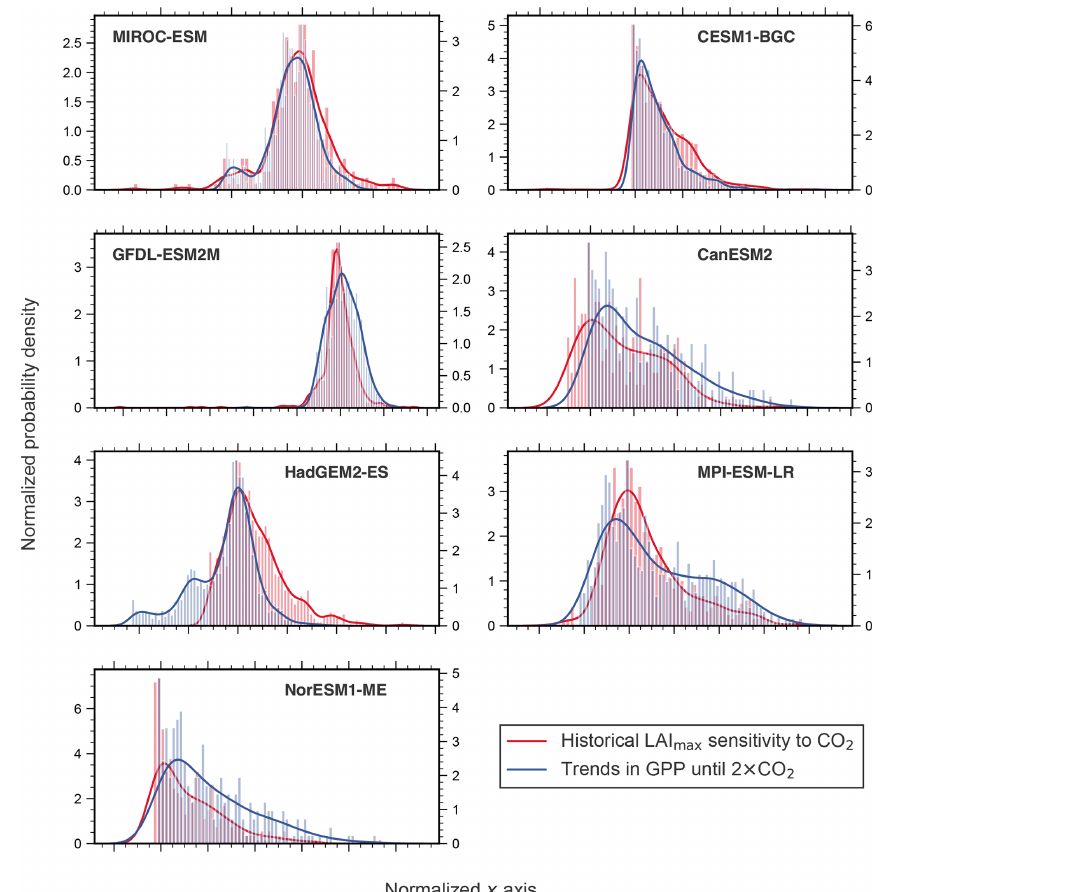
Figure A2. Similar pixel distribution of the predictor and predictand in each model, except HadGEM2-ES. Histograms and associated probability density functions (Gaussian kernel density estimation) of LAI sensitivity to ω (red, left y axis, historical simulations) and temporal trends in GPP (blue, right y axis, 1pctCO2, until 2 × CO 2 ) for NHLs are shown for all CMIP5 models. Only significant pixels are included (Mann–Kendall test, p < 0 . 1). To obtain comparability between the distributions, the x axis was normalized and has only a qualitative